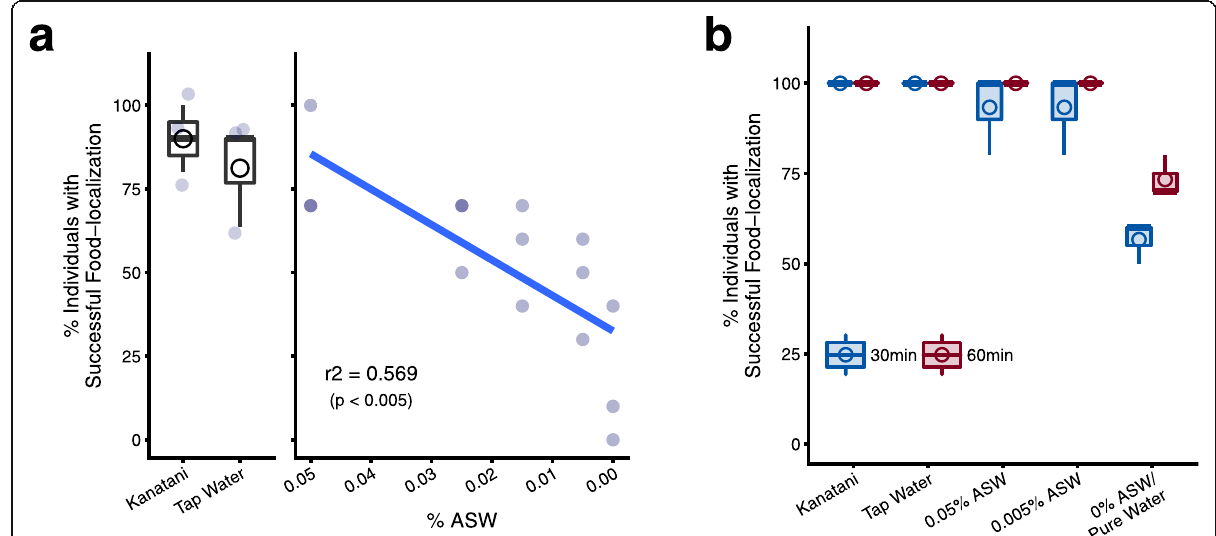
Fig. 4 The environmental water affects the sensitivity of the response to foods. a . The percent of individuals that reached the food within 10 min. Although the food-localization behavior of planarians tested in Kanatani water, tap water, or 0.05% ASW showed a high score, the scores of the food-localization were gradually decreased according to the reduction of the concentration of ions in the environmental water. Regression analysis showed a good correlation between the food-localization behavior and the concentration of the ions. n = 10; 3 independent experiments. b . The percent of individuals that reached the food within 30 or 60 min. Prolongation of the assay time resulted in improvement of the score of the food-localization behavior, indicating that low concentrations of ions in the environmental water may reduce the ability to elicit the food-localization